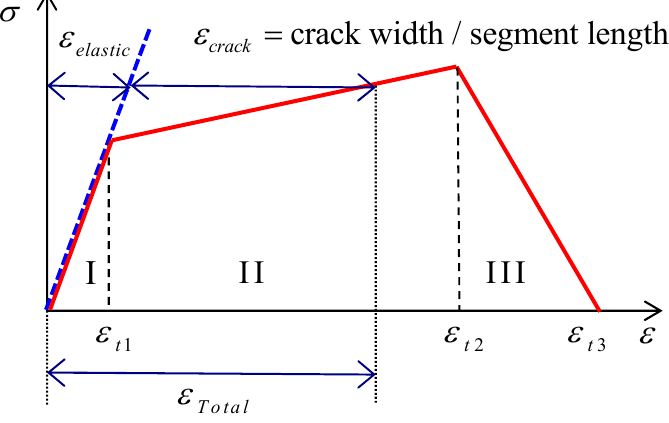
Figure 8. Total tensile stress–strain relationship in uniaxial